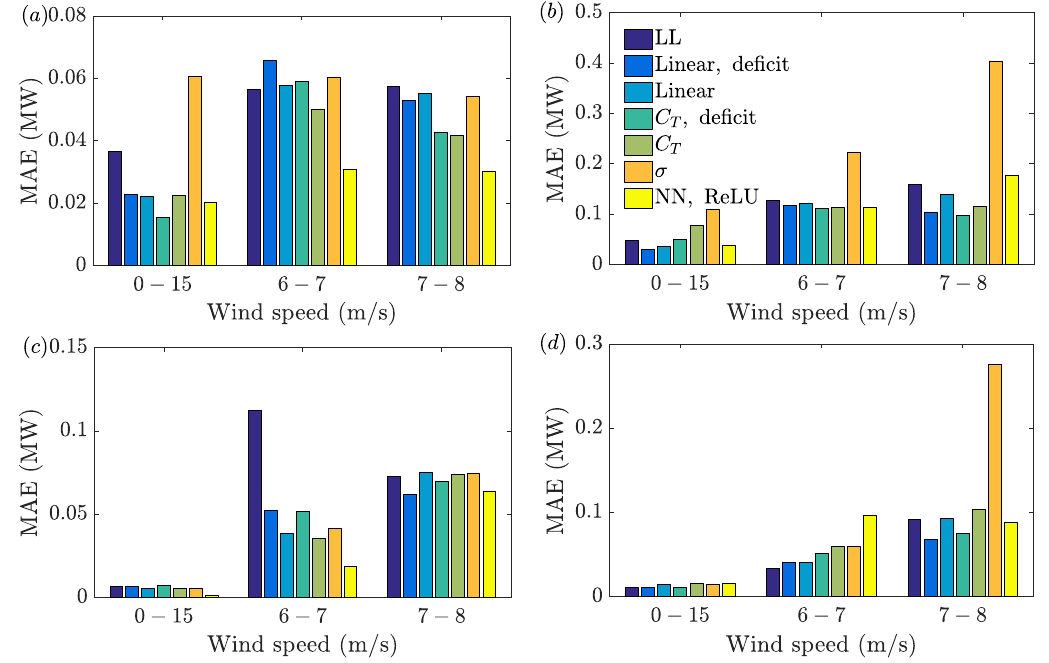
Figure 5. ( a , b ) Mean absolute errors for the various low-order model architectures for the ( a ) training and ( b ) development datasets for 250 ◦ inflow. ( c , d ) Mean absolute errors for the various low-order model architectures for the ( c ) training and ( d ) development datasets for 330 ◦